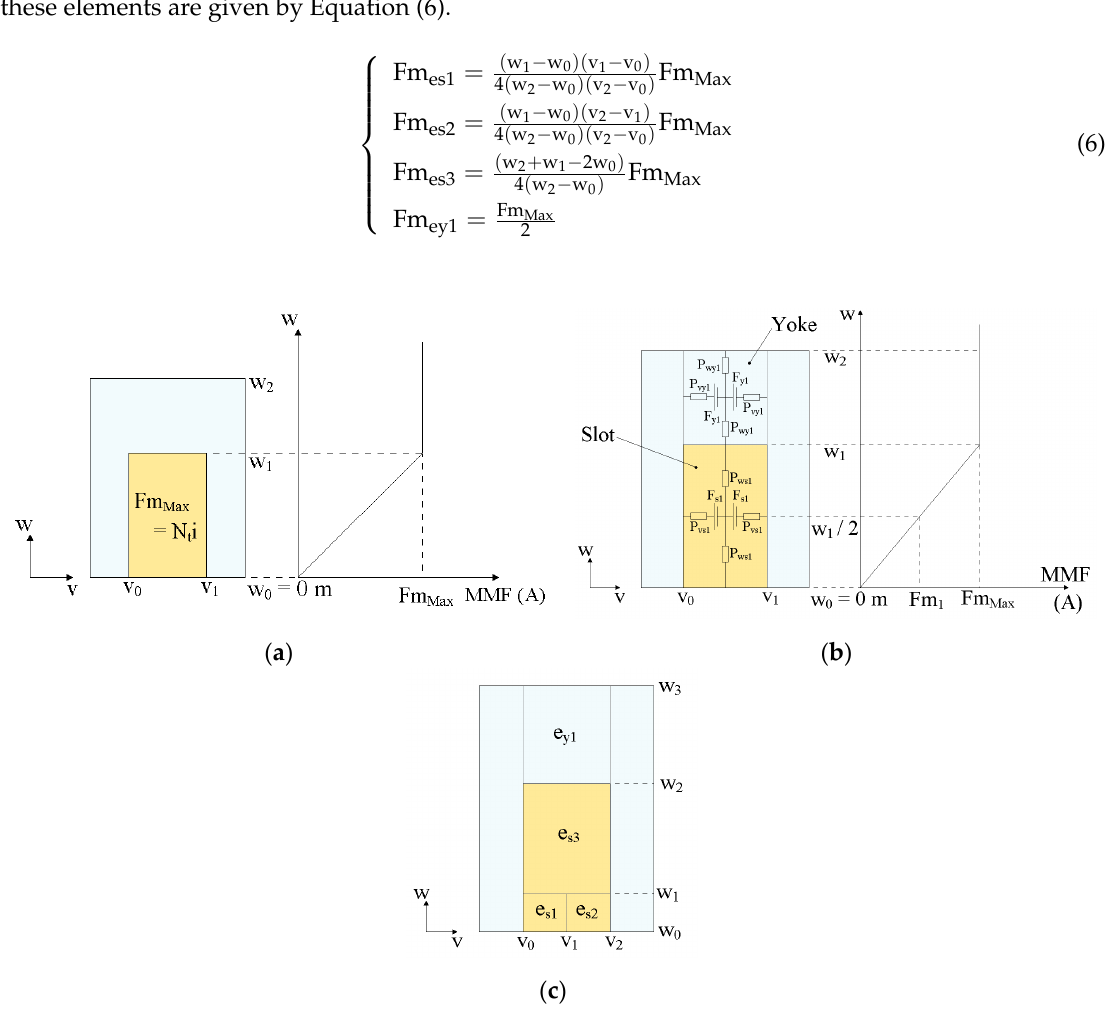
Figure 23. Armature end-windings modeling. 5.2.3. Air-Gap Modeling In order to model the air-gap, two types of reluctance elements can be used: Unidirectional (radial direction for radial flux rotating machines) or multi-directional reluctance blocks (see Figures 9 and 17). This depends on the global quantity which is sought (flux or torque), the calculation time constraint and the sought precision [25,82]. For the study of flux control capability the use of unidirectional reluctances is largely enough. Furthermore, the use of unidirectional reluctances implies a reduced number of nodes, as compared to multi-directional reluctances, and as a consequence a reduced calculation time. Figure 24 illustrates, on a simple 2D case, how the value of the reluctance between a static element and a moving element is calculated as a function of the moving armature relative position. For clarity reasons, only one static element e 1 from the stator and one moving element e 2 from the moving armature are represented (Figure 24a). The value of the unidirectional permeance between the two elements (see Figure 24b) is given by Equation (7) where, l ag is the air-gap length, L a is the elements axial length (it is supposed to be the same for both elements in 3D problems), and Δ v is given by Equation (8). α and β values are given by Equation (9).